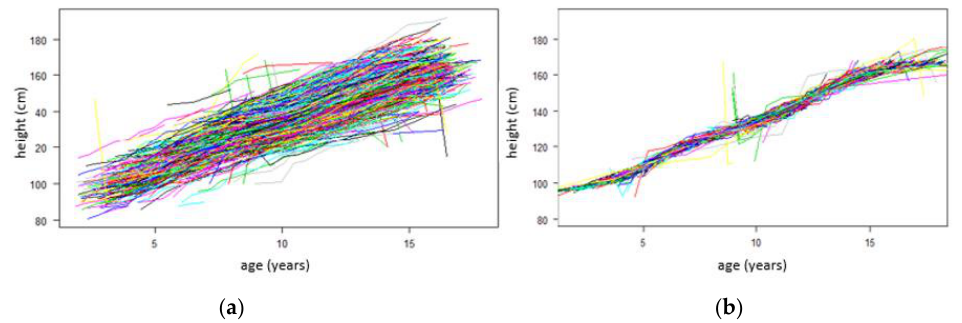
Figure 1. Growth curves for boys and girls.